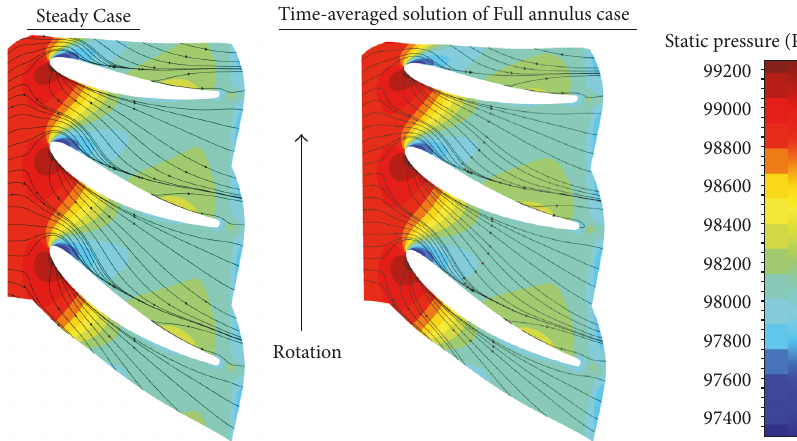
Figure 8: Numerical rotor static pressure contours and streamlines near the hub.